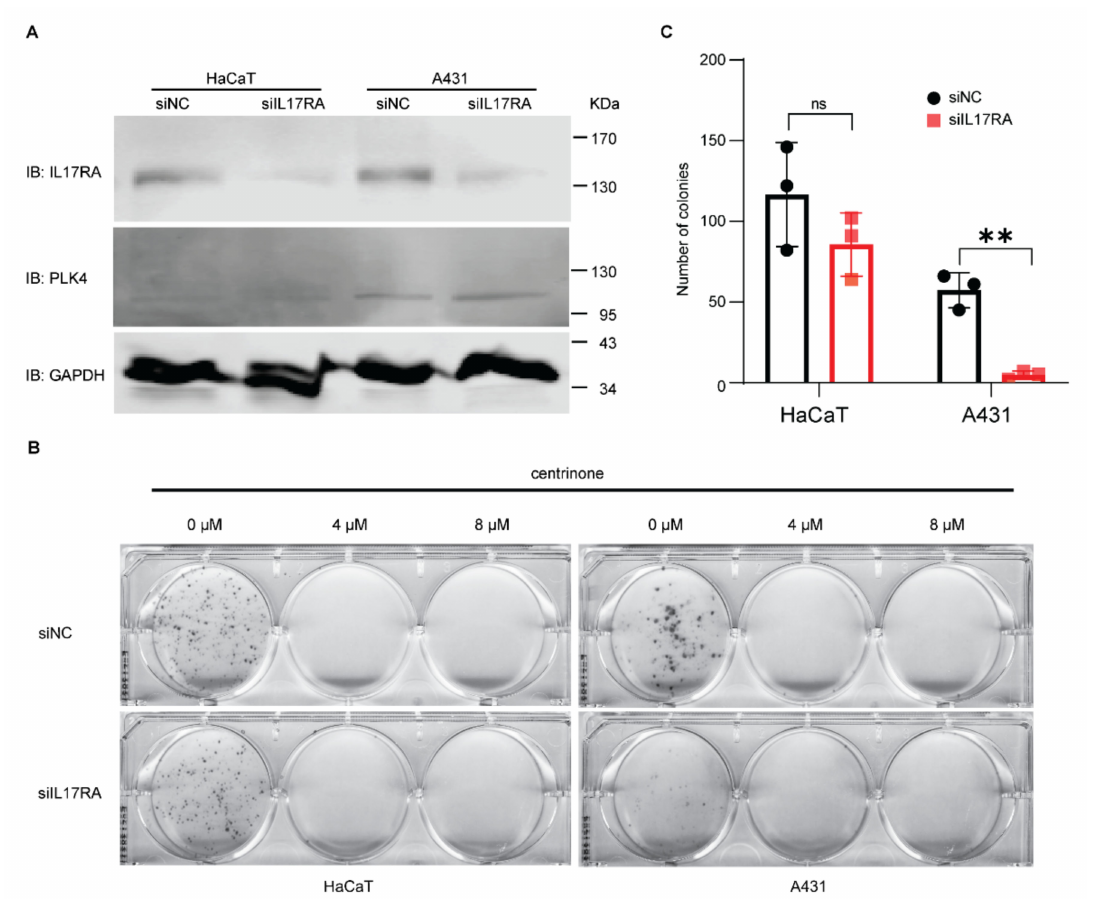
Figure 2. Effect of IL17RA knockdown and centrinone on squamous skin cancer cells. ( A ) Endoge- nous IL17RA of HaCaT and A431 was knocked down using small interference RNA of IL17RA. ( B , C ) Colony formation assay was conducted to determine the effect of IL17RA knockdown and inhibition of PLK4 on the proliferation of normal skin cell line HaCaT and squamous skin cancer cell line A431. A two-tailed Student’s t test was applied to analyze statistical significance. Error bar represents mean ± standard deviation (SD); ns—no significance; ** — p <